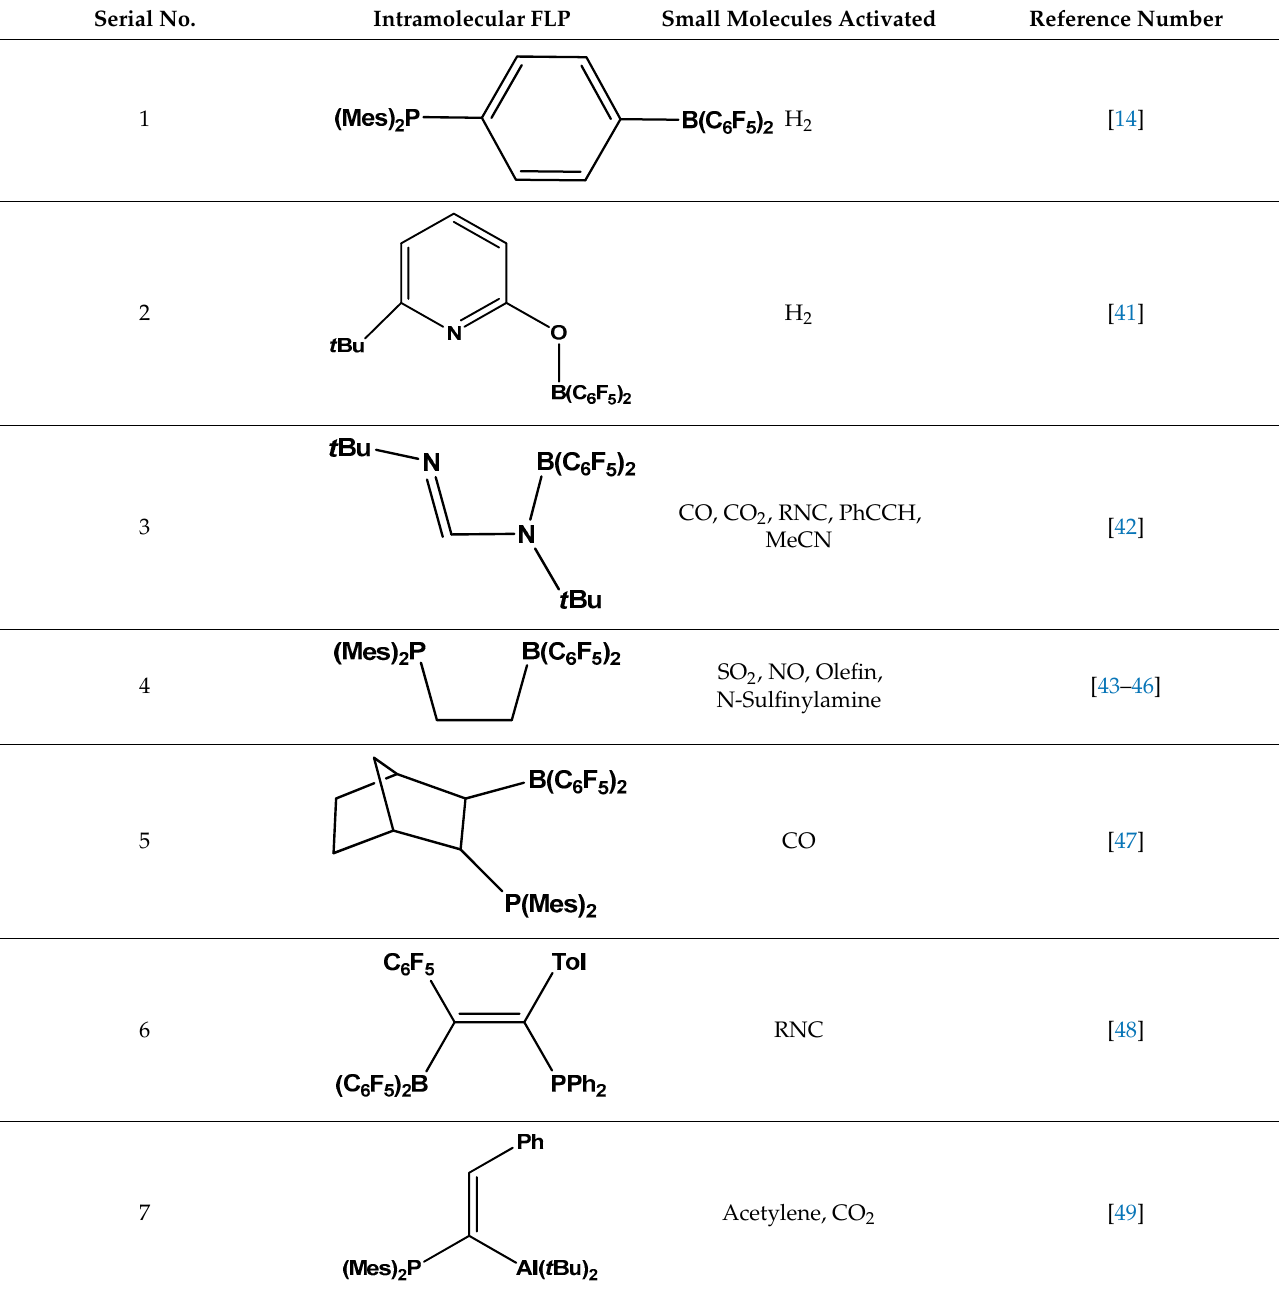
Table 3. A comparison of energetics for H 2 activation by TM and FLPs.